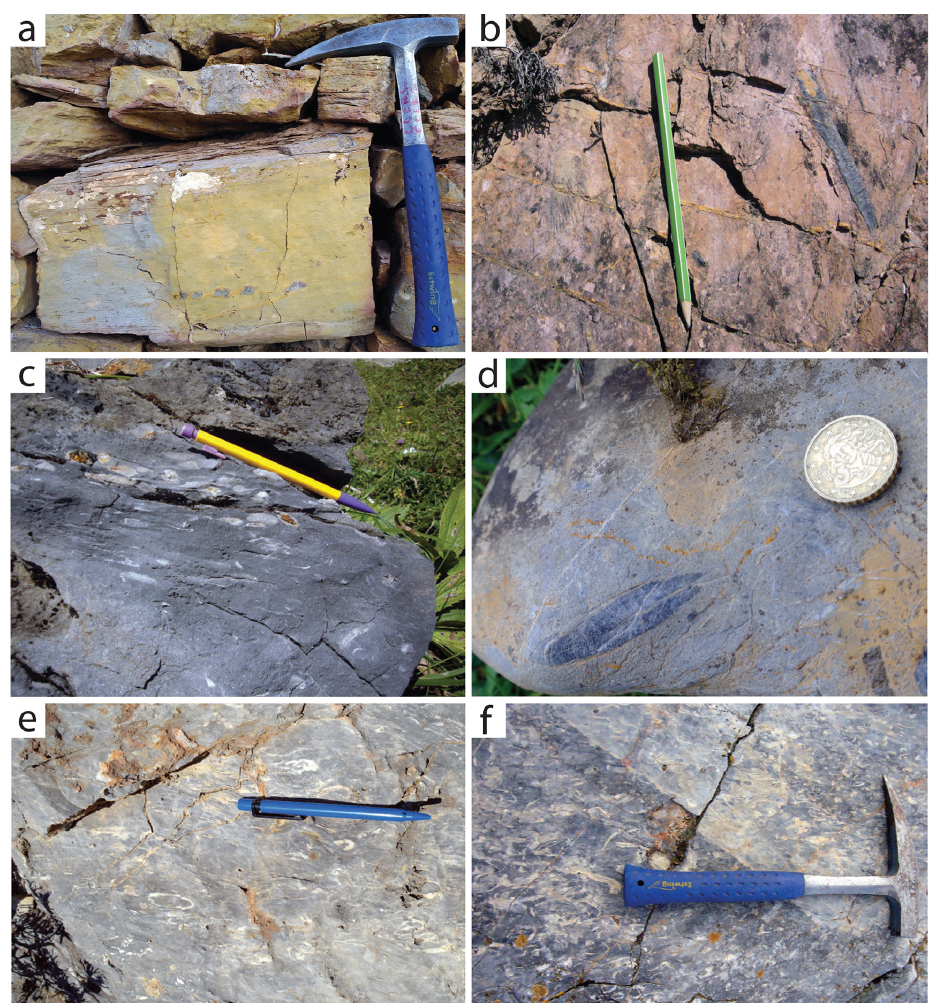
Figure 5. Examples of deformed Mesozoic fossils from the NPZ. Boudinaged (a) and elongated (b) belemnites and pecten in the Bas-Agly. Ductiley deformed bivalves and belemnites at Port de Saleix (c) and Col Dret (d) . Deformed Urgonian rudists in the Bas-Agly ( e and f